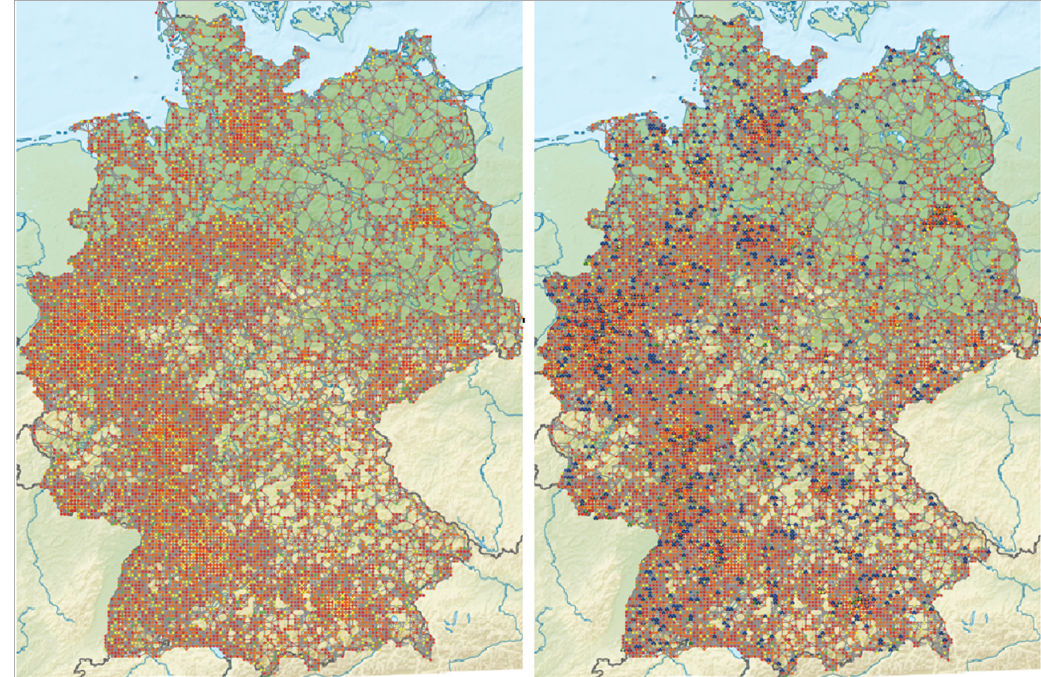
Figure 4. Depiction of interconnected household agents in Germany before and after an exemplary diffusion process ( t = 15 years). The different colors represent the individual adopter group; the blue dots on the right represent households owning a battery electric vehicle (BEV)/plug-in hybrid electric vehicle (PHEV) after the considered period (own illustra- tion).